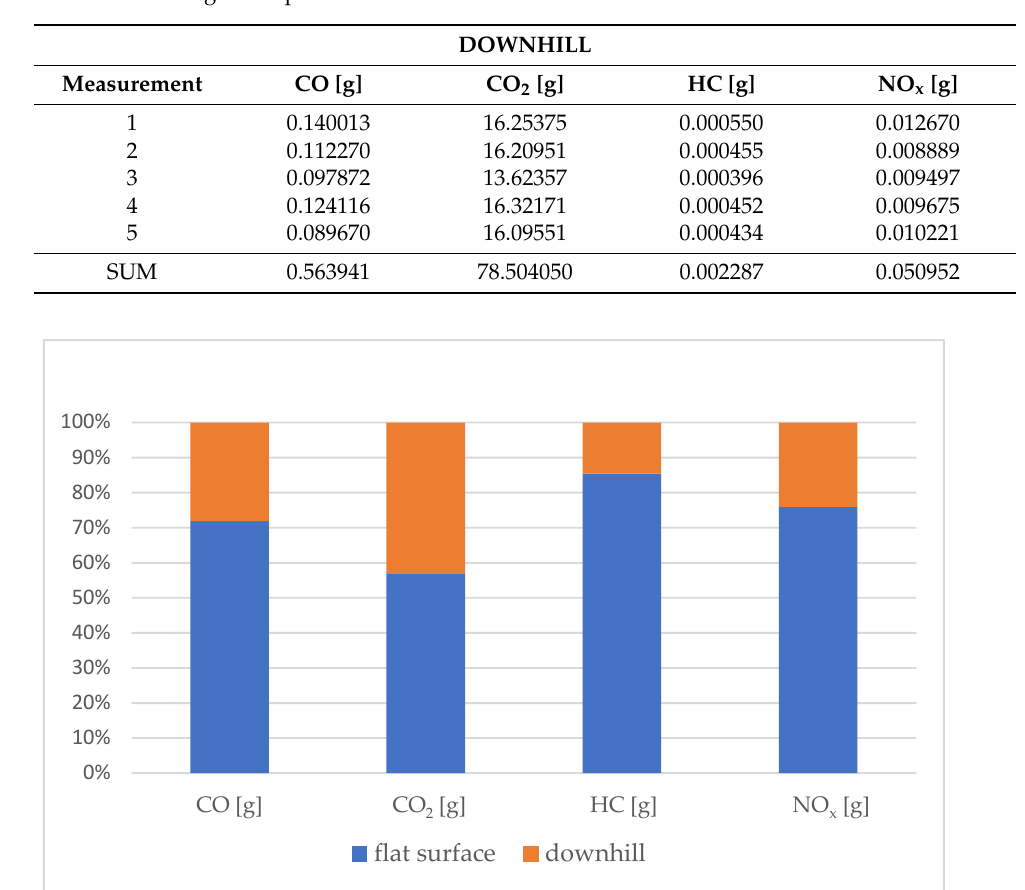
Table 5. Exhaust gas composition for five selected accelerations—downhill. Source: author.